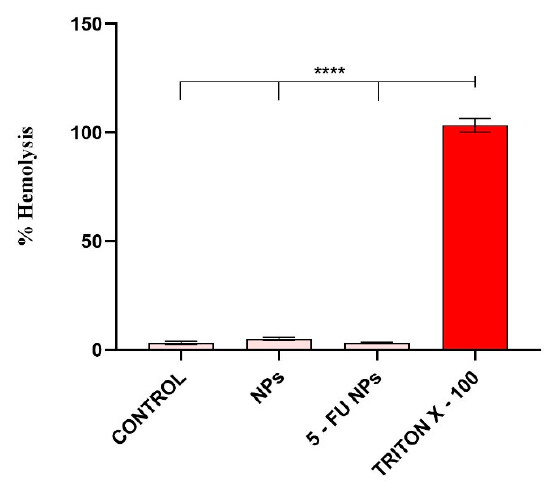
Figure 8. Hemocompatibility of SF/PEG NPs ± 5-FU as revealed by the blood hemolysis assay after incubation with 12 mg/mL SF/PEG NPs ± 5-FU (**** p ≤ 0.0001).